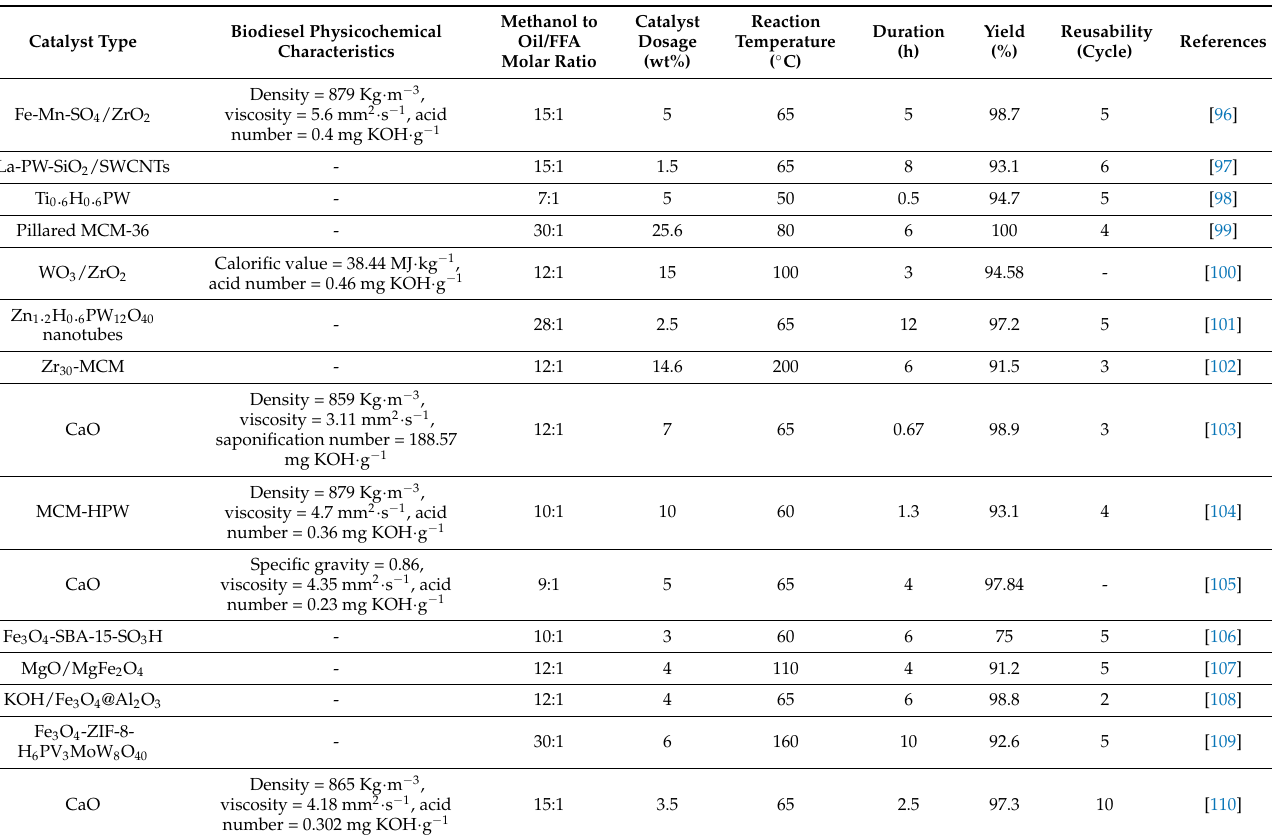
Table 3. Heterogeneous catalysts used for biodiesel production along with the yield and reac- tion